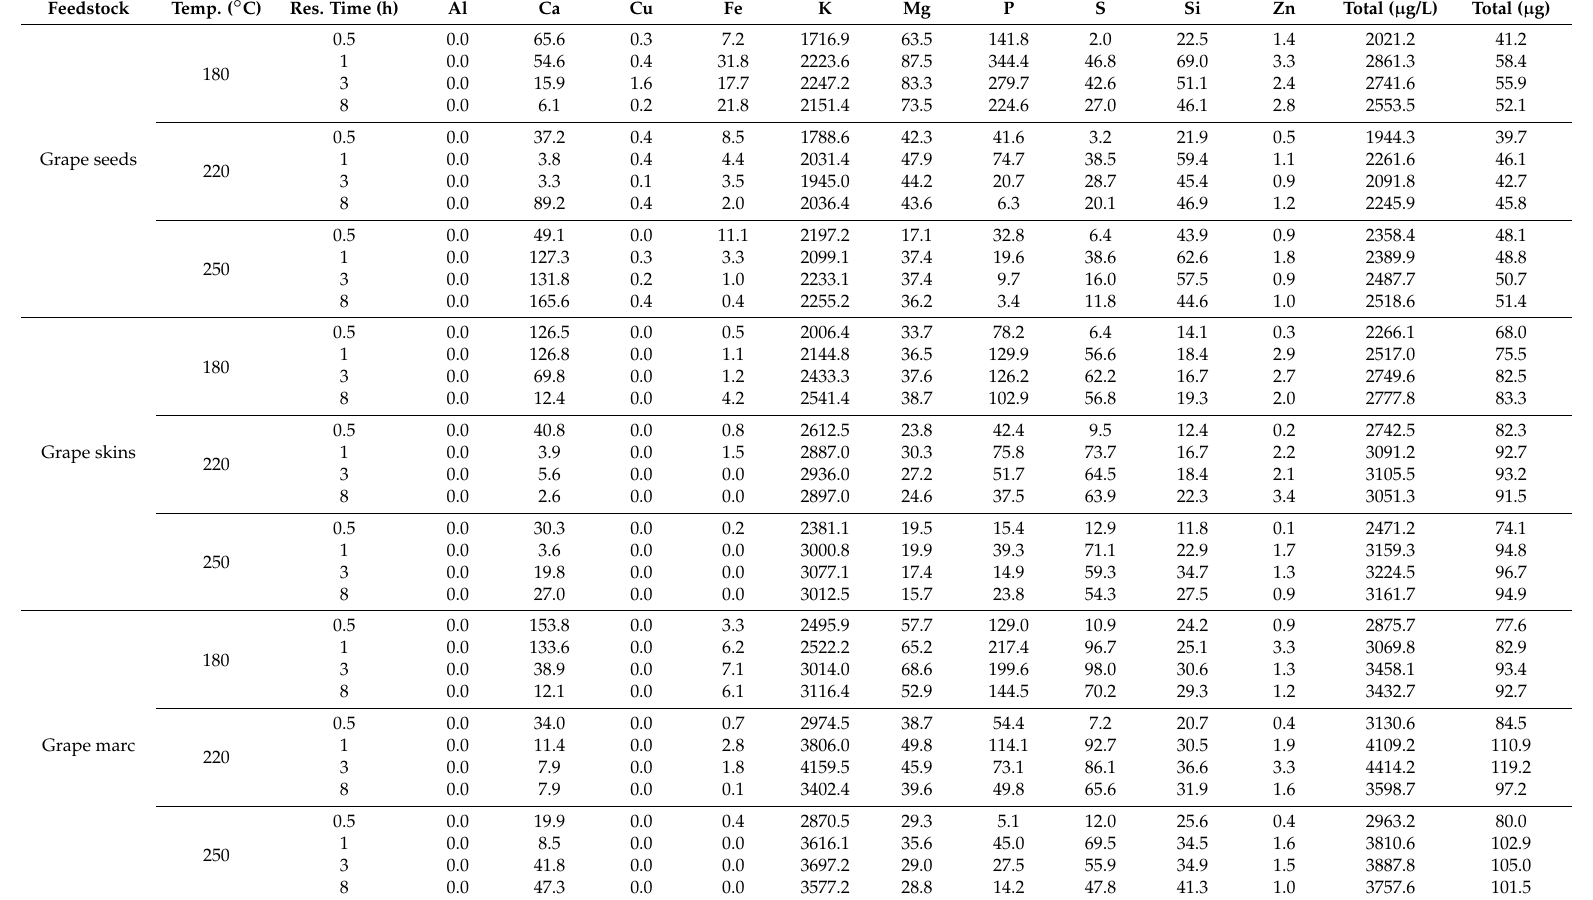
Table 3. ICP data of the liquid obtained after HTC of grape seeds, skins and marc. All the values are in µ g/L.